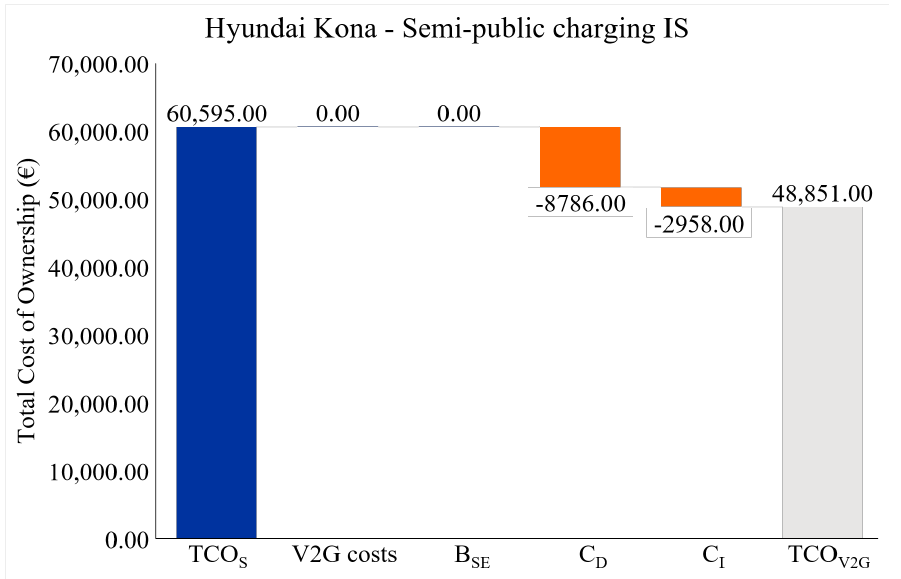
Figure A10. Standard and V2G TCO of a Hyundai Kona in a semi-public charging case provid- ing IS ( TCO S = Standard TCO, B SE = benefit of saved electricity costs from the grid, C D = direct compensation, C I = indirect compensation, TCO V 2 G = V2G TCO); source: own compilation).